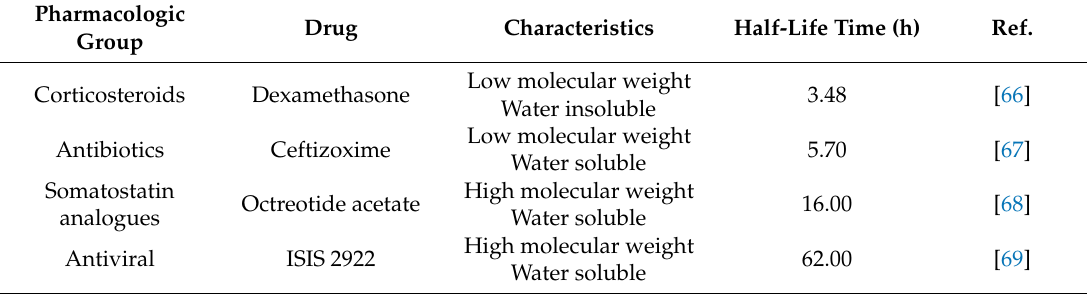
Table 1. Vitreous half-life times for intravitreally administered drugs with di ff erent pharmacokinetic characteristics.